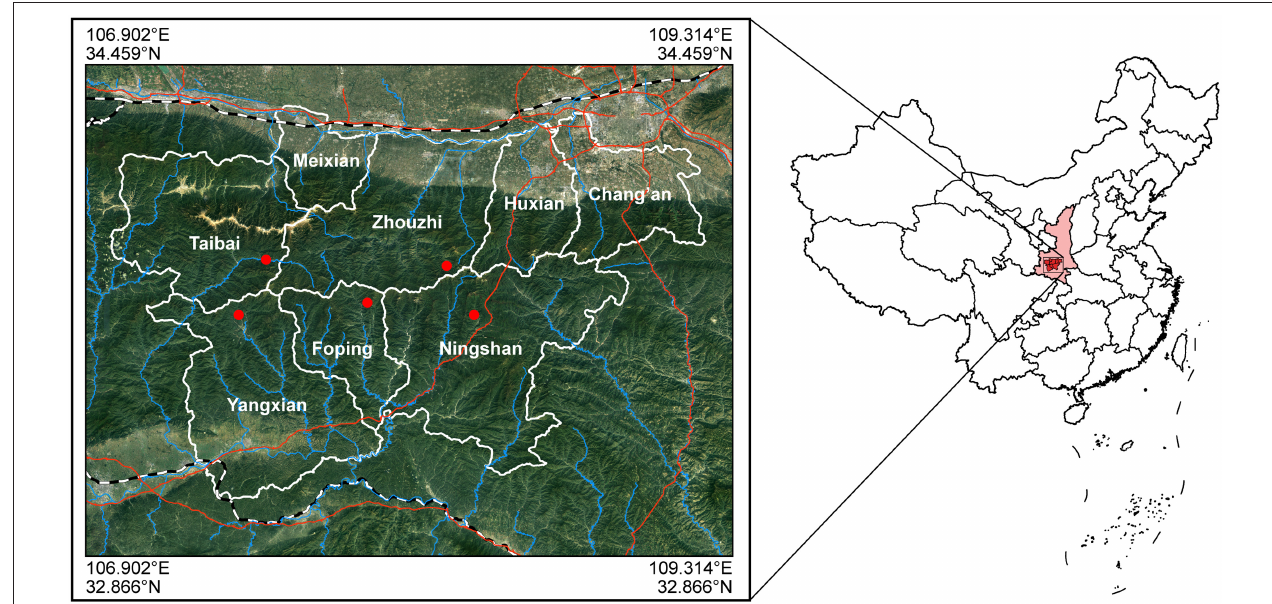
FIGURE 1 | Sampling sites: the range of coordinates were 107.52-108.38 ◦ E, 33.64-33.82 ◦